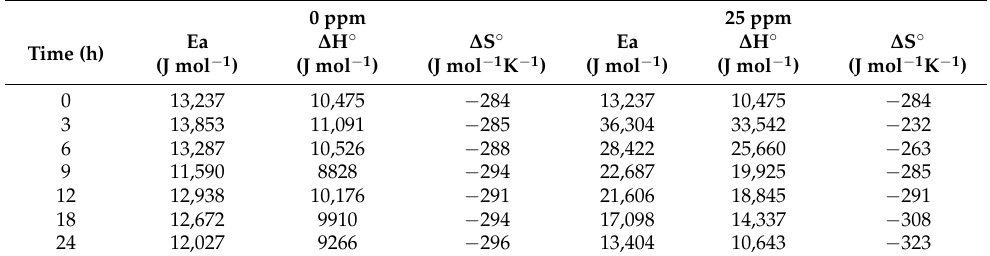
Figure 14. Arrhenius plot, for the calculation of Ea, as a function of immersion time: ( a ) without inhibitor, ( b ) with 25 ppm inhibitor. Table 1. Activation parameters of the corrosion process of API-X52 steel in the absence and presence of inhibitor.